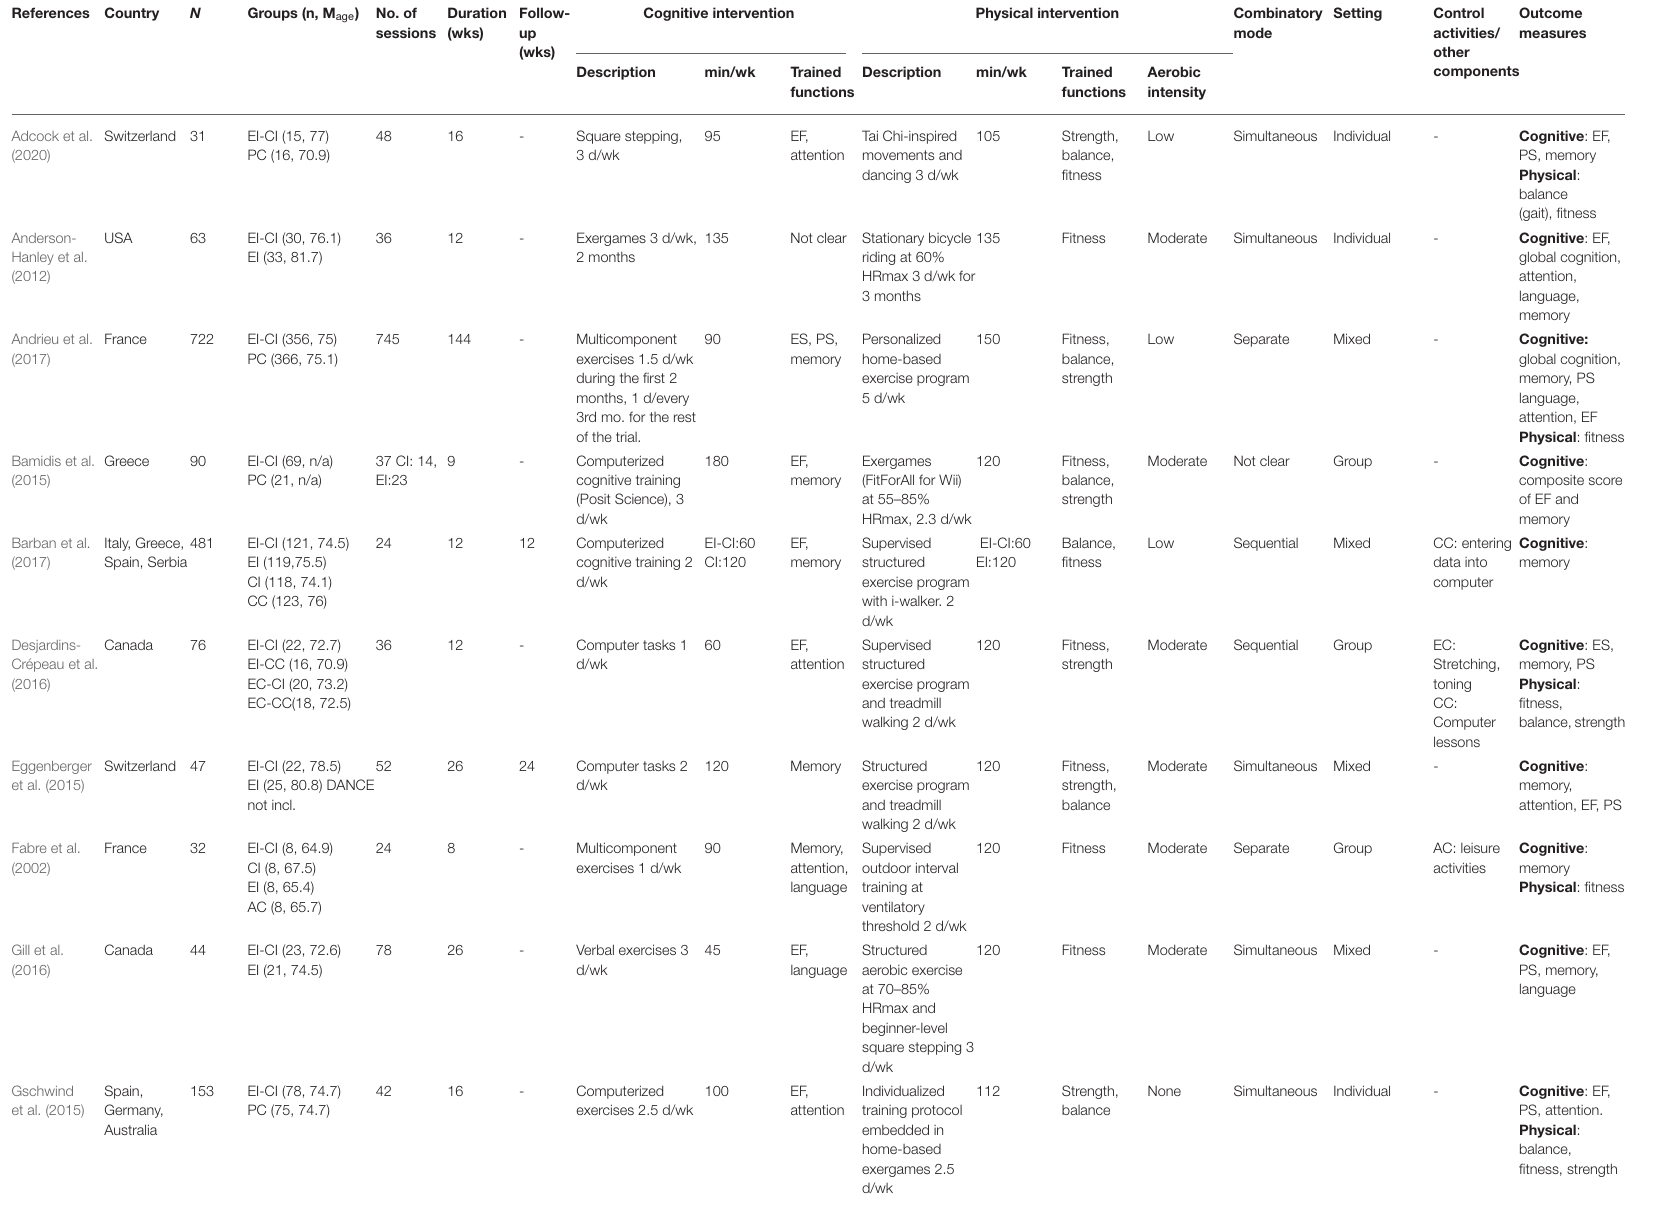
TABLE 1 | Study designs and descriptive data of the primary studies included in the